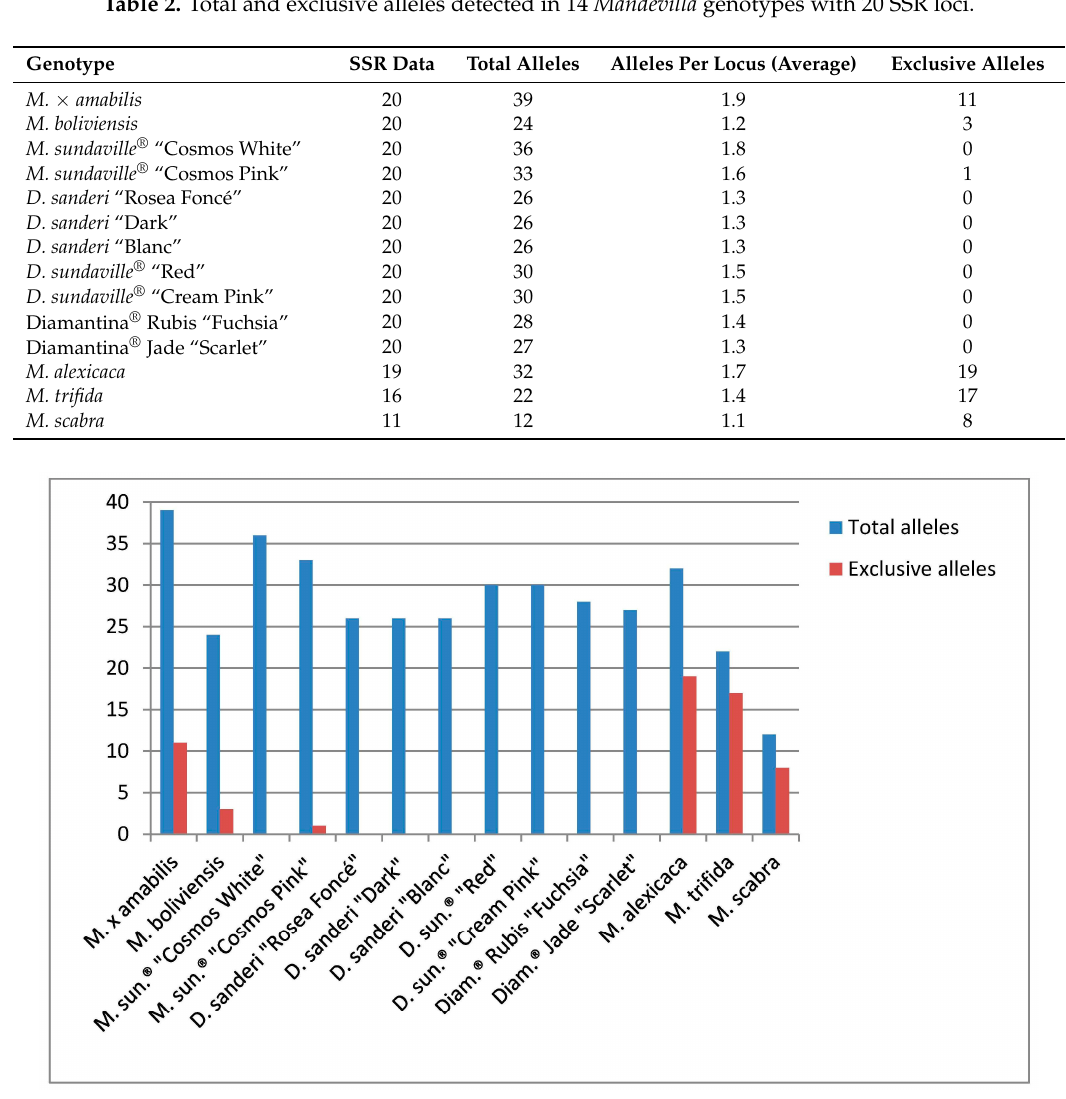
Figure 1 . Total and exclusive alleles detected in 14 Mandevilla genotypes with 20 SSR loci. Figure 1. Total and exclusive alleles detected in 14 Mandevilla genotypes with 20 SSR